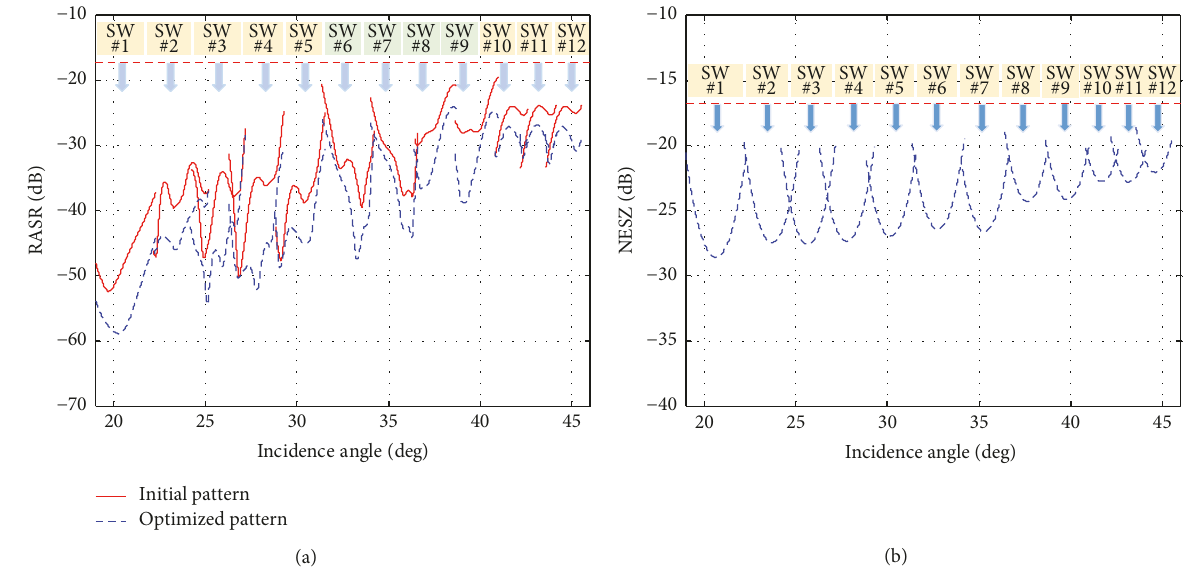
Figure 13: Analysis results for SAR system performance (a) RASR. (b)